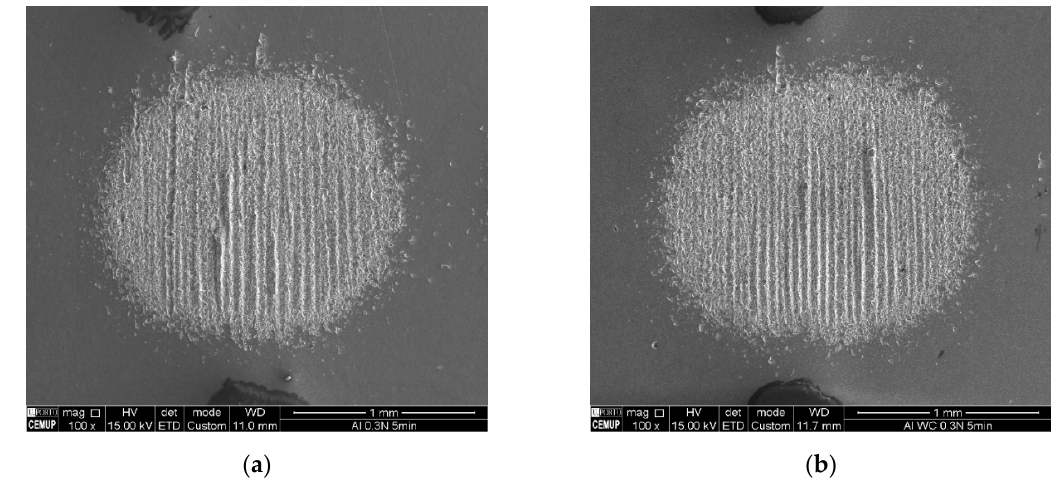
Figure 10. SEM/SE images showing craters and morphology of the grooves on: ( a ) Non-reinforced Al and ( b ) Al-WC composite.